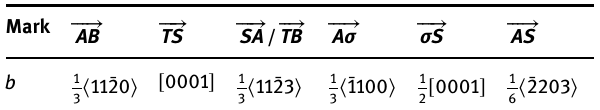
Figure 9: Temperature change during